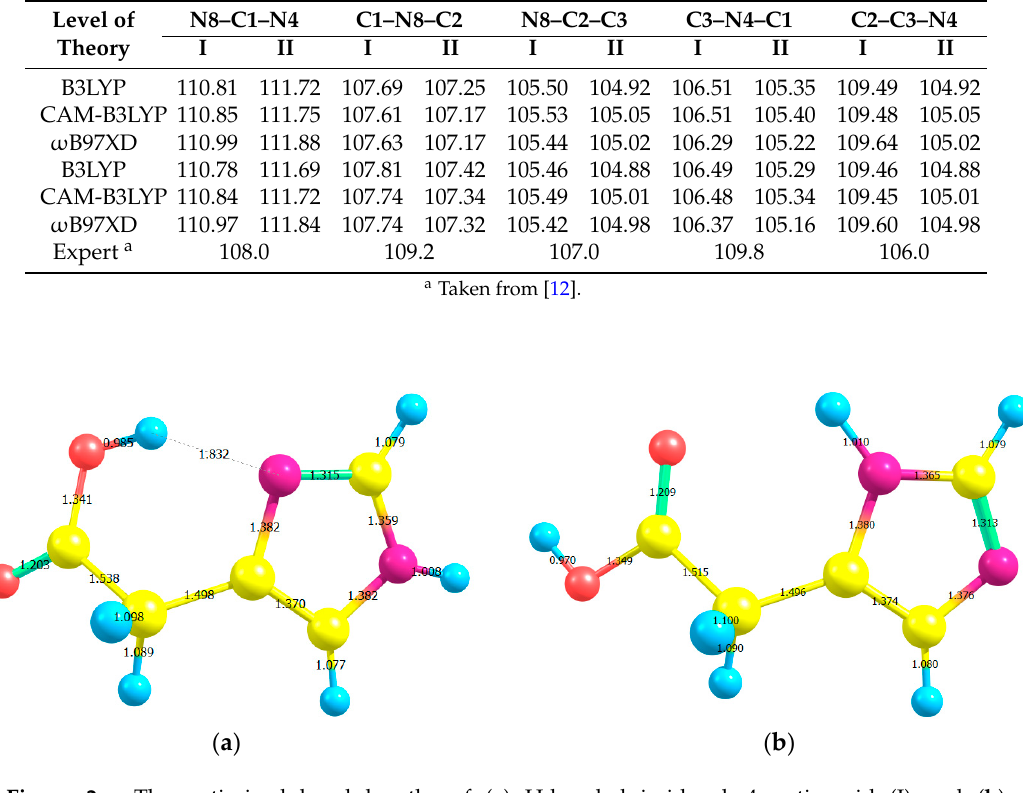
Table 2. The bond angles (degrees) of the optimized geometries of H-bonded imidazole-4-acetic acid (I) and imidazole-5-acetic acid (II) using B3LYP, CAM-B3LYP, and ω B97XD functionals with 6-311++G** (three top lines) and aug-cc-pvdz (three bottom lines) basis sets. The crystal structure of imidazole-4-acetic acid hydrochloride is given for comparison purposes.